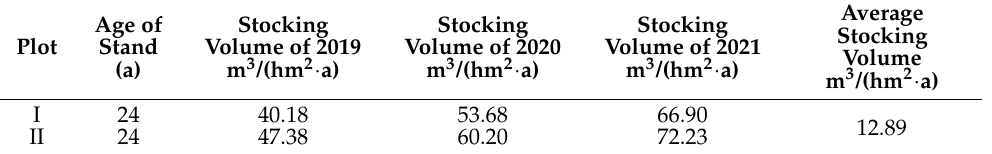
Table 3. Stocking volume of Liquidambar formosana Plantation in Changsha.